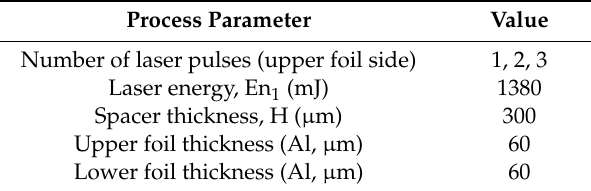
Table 4. Number of laser pulses on the upper foil side and other experimental process parameters. Process Parameter